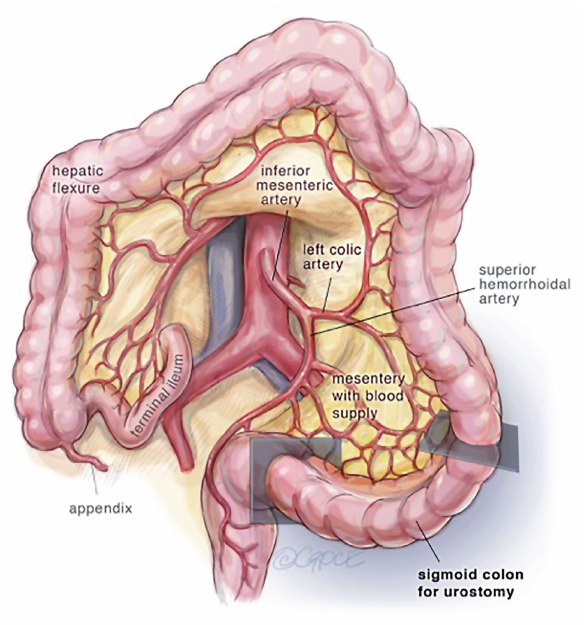
Figure 2 - Sigmoid isolation for urinary